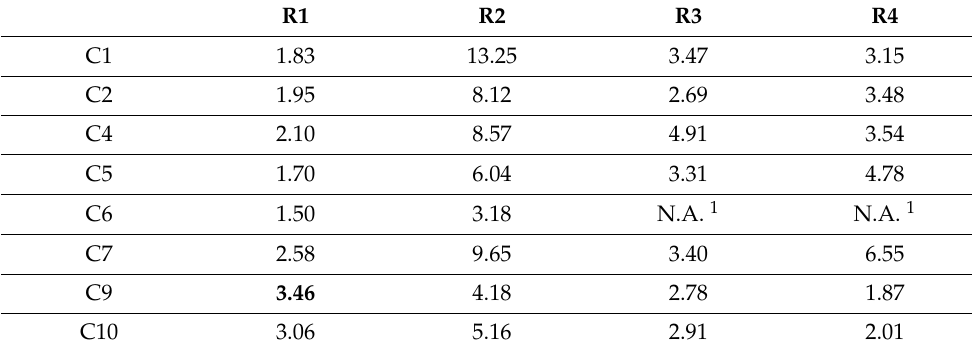
Table 3. GMMR for configurations presented in Figure 7 (170 mm